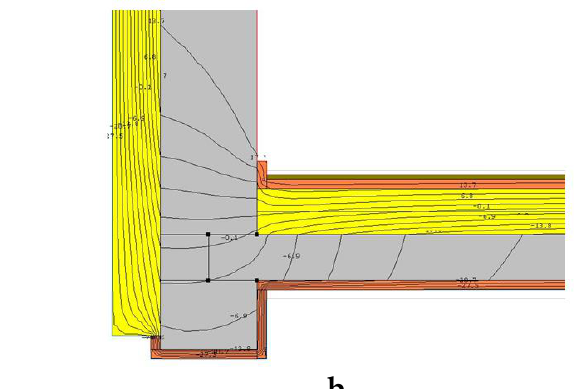
Figure 8. Floor plan of a residential building (Section 2 — wall between columns and details of nodes): ( a ) — insulation with thermal insulation boards; ( b ) — seamless insulation with rolled poly-